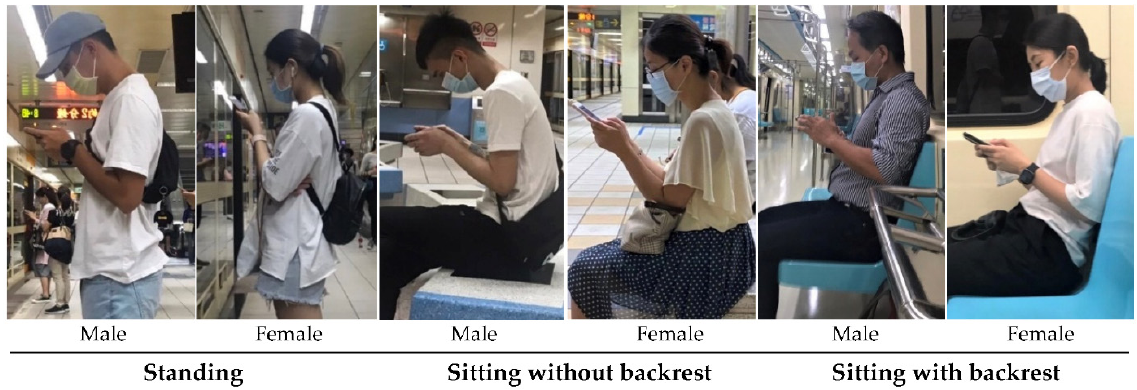
Figure 2. Three typical postures of smartphone use for both genders in the field study.